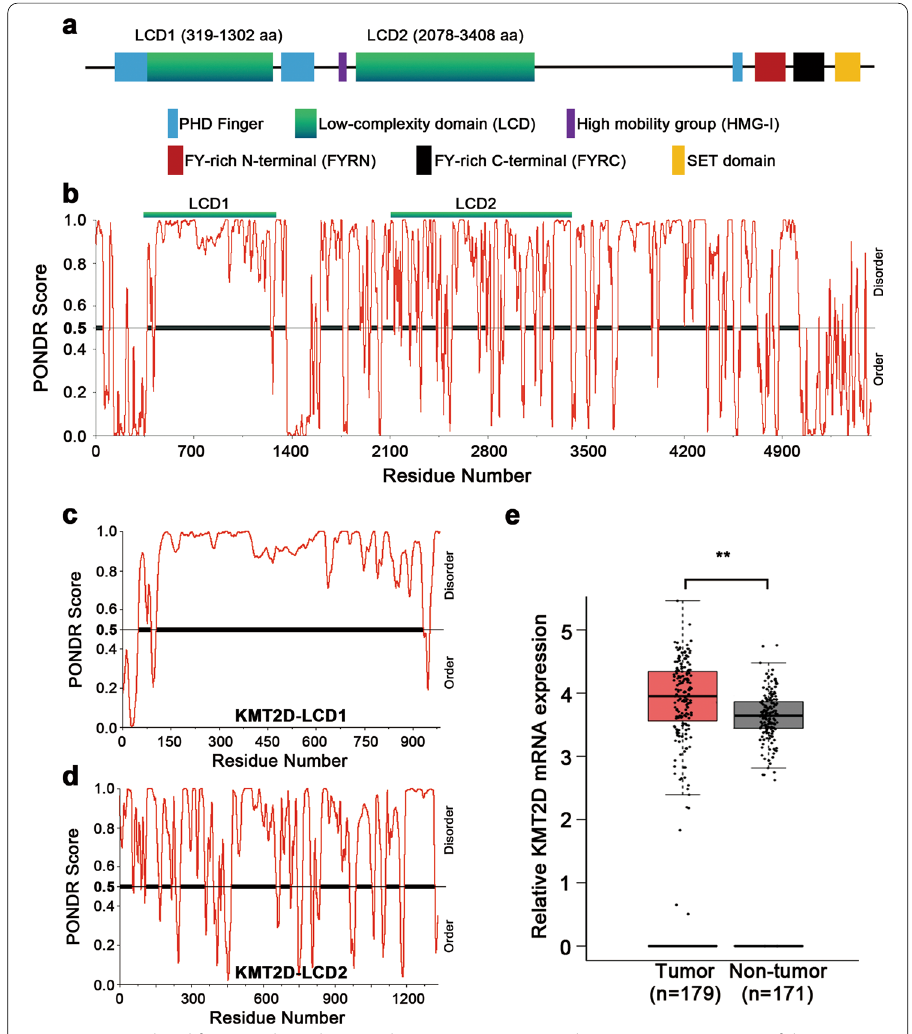
Fig. 1 Structural and functional insights into the KMT2D protein. a Schematic representation of the domain structure for KMT2D protein. KMT2D contains two clusters of plant homeotic domains (PHDs) in the amino-terminal region. The second cluster can recognize unmethylated histone H4 tails. On the C terminus, FY-rich N-terminal (FYRN) and FYR C-terminal (FYRC) and an enzymatically active SET domain are closely connected to generate a functional and stable protein. A high mobility group I (HMG-I) binding motif (frequently found in transcription factors and cofactors) and a PHD domain are present in the protein sequences. The two domains of interest are indicated as LCD1 and LCD2. b – d Analyses of KMT2D, KMT2D LCD1, and KMT2D LCD2 using the PONDR database. KMT2D protein has two intrinsically disordered regions with multi-phosphorylation sites and a high proportion of proline and glutamine. e Analyses of KMT2D expression in pancreatic cancer (Tumor, n 179) and normal tissue (Not-tumor, n 171) based = = on previously published gene expression array data listed in The Cancer Genome Atlas (TCGA) database. In contrast to normal tissues, significant overexpression of KMT2D was found in pancreatic cancer tissues (p <